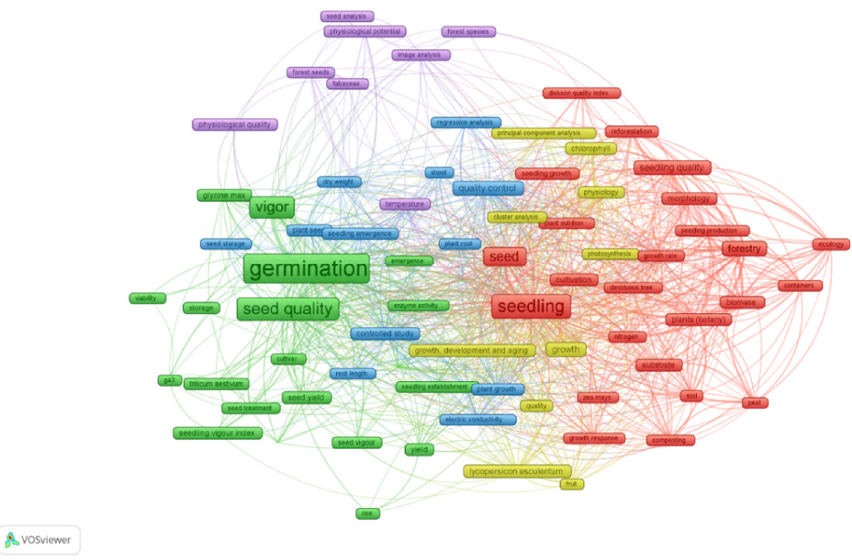
Figure 3. Bibliometric map generated from an analysis of the most repeated keywords in articles published during the period 1989–2020. Different colours represent the diversity of thematic clusters found and the associated keywords: Red ( cluster 1 ), green ( cluster 2 ), blue ( cluster 3 ), yellow ( cluster 4 ), and purple ( cluster 5 ).